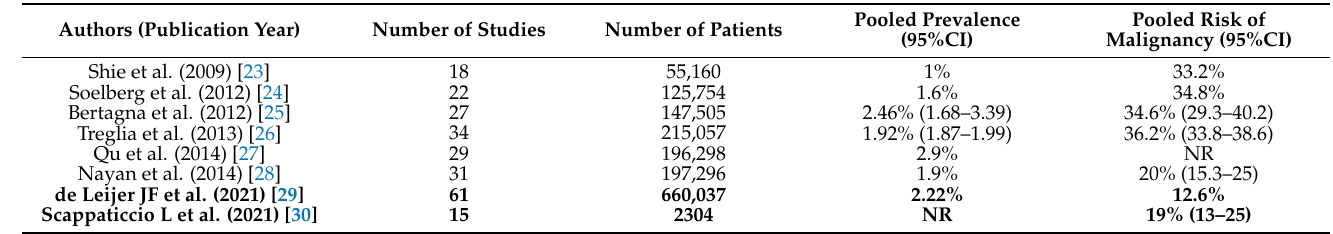
Table 1. Prevalence and risk of malignancy of 18 F FDG PET and PET/CT thyroid incidentalomas according to published meta-analyses (adapted from Piccardo A et al. Rev Endocr Metab Disord. 2019 [21,22].